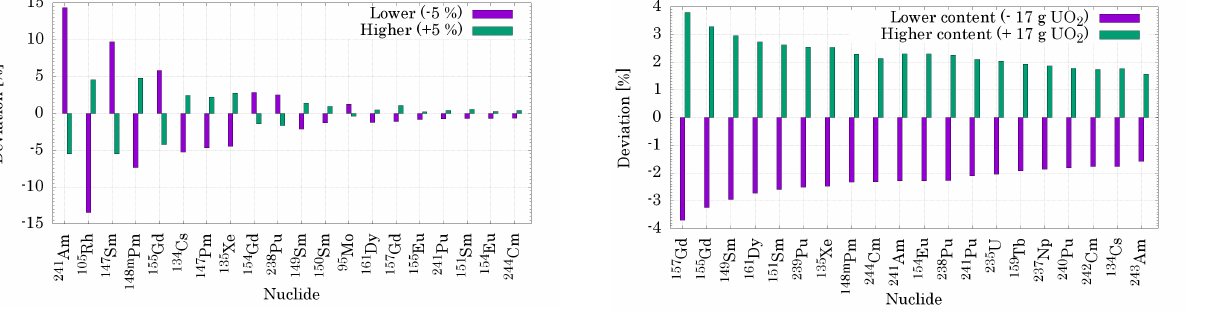
Figure 8. Effect of change in uranium content on